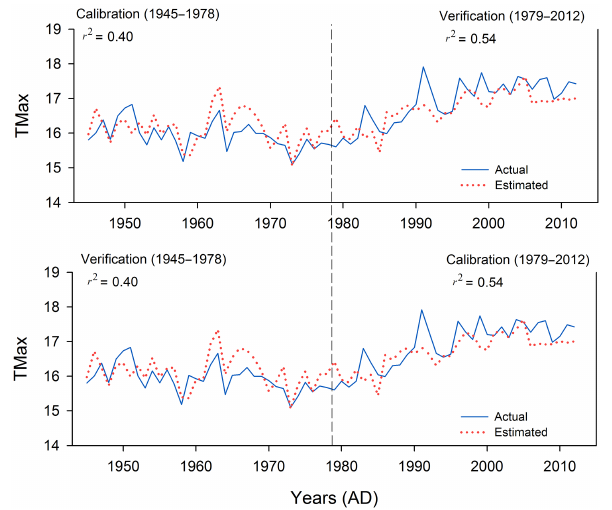
Figure 8. Calibration and verification results of the CRU data-based T max _21_Sep − 1